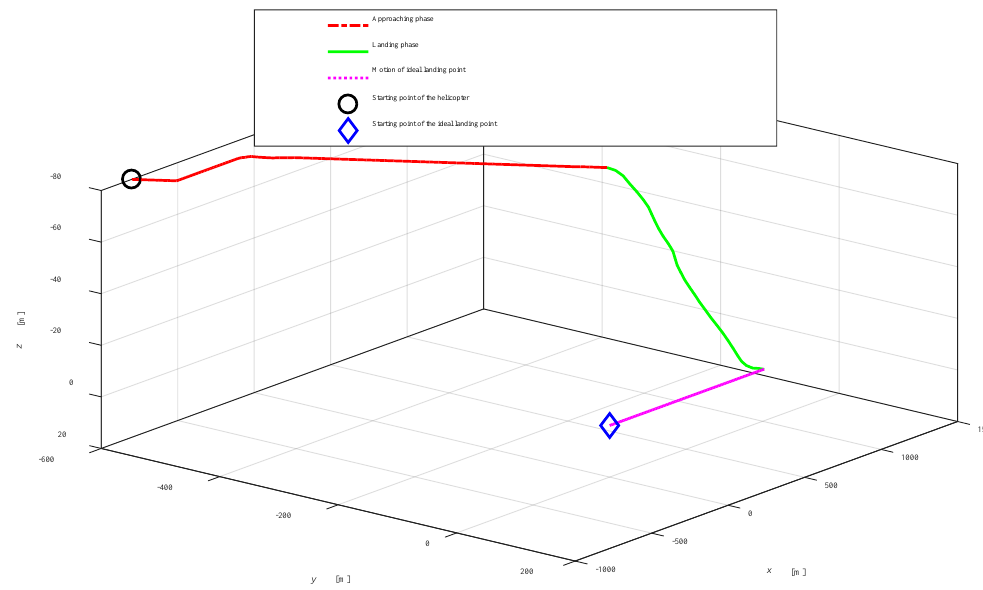
Figure 8. Landing path of the helicopter and motion of the ideal landing point.